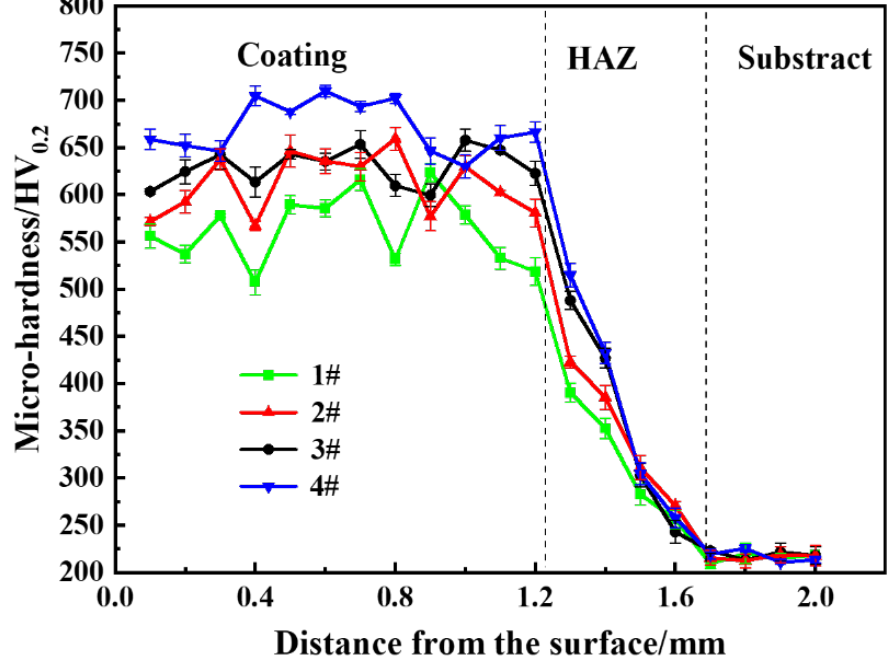
Figure 5. Microhardness distribution of the coating along the vertical direction under the action of different field-assisted types.